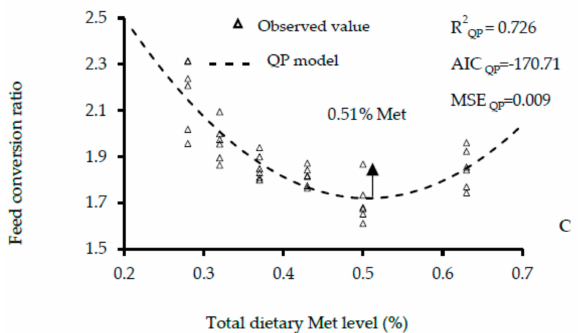
Figure 2. Regression models plot of growth performance as a function of total dietary Met level (0.28%, 0.32%, 0.37%, 0.43%, 0.50%, and 0.63% Met) of female rapidly growing yellow-feathered chickens between 0 and 21 days of age. Correlation coe ffi cient ( R 2 ), Akaike information criteria (AIC), and mean squares error (MSE) are indicators used in evaluating fitness of models. ( A ) The optimum response arrow pointing at 0.51% Met by the best fitting regression model. ( B ) The optimum response arrow pointing at 0.51% Met identified by the best fitting model. ( C ) The optimum response arrow pointing at 0.51% Met.